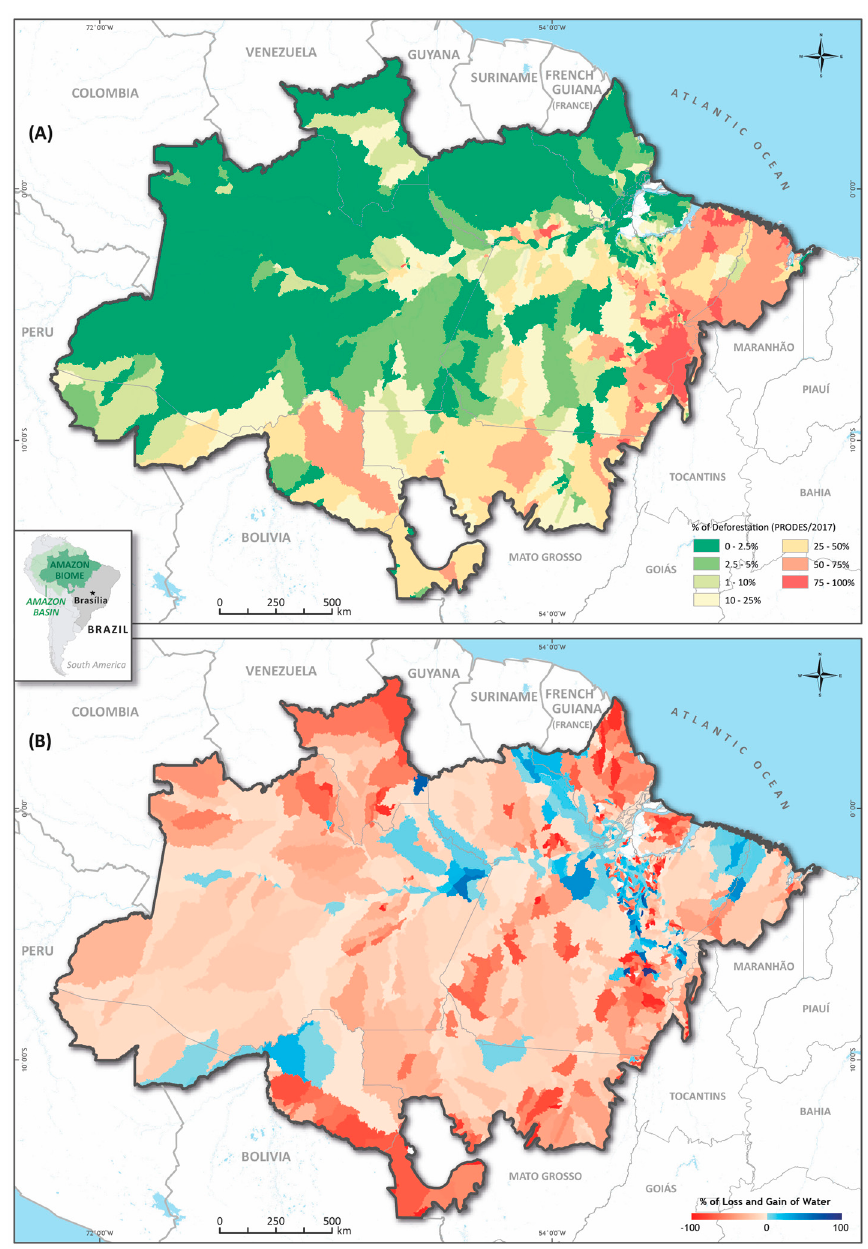
Figure 9. Proportion of forest (green) and deforested areas (orange) at level 4 watersheds ( A ), and gains and losses of surface water in 2017 per watershed relative to the mean difference from 1985 to 2017 ( B ).